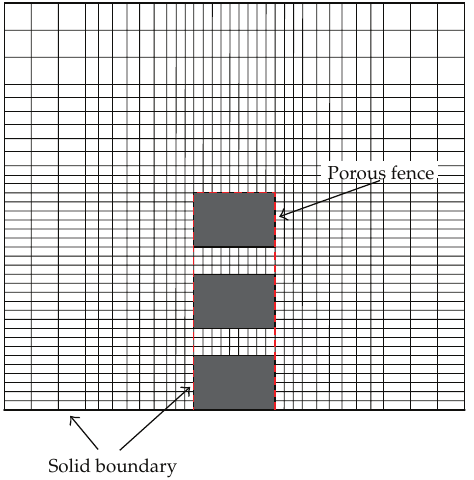
Figure 4: Computational grid local to the porous